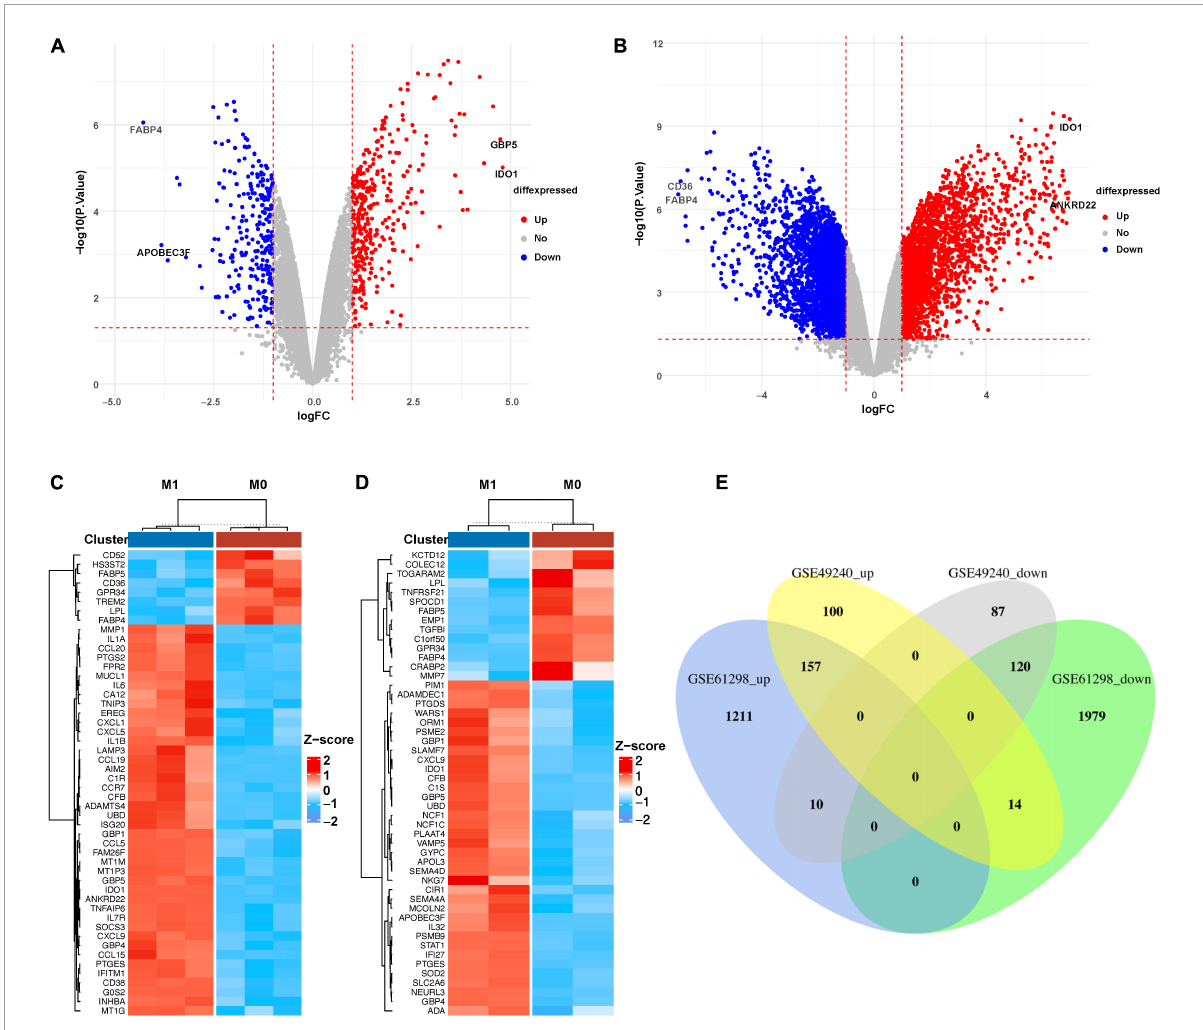
FIGURE1 Identification of DEGs in M1 macrophages datasets. (A) Volcano diagram of DEGs in GSE49240 and (B) volcano diagram of DEGs in GSE61298, the cut-off value of –log10( P -value) is –log10(0.05), cut-off value of |log 2 fold change| is 1, red and blue, respectively, represent relatively high and low expression of the mRNA. (C) Heatmap of DEGs in GSE49240 and (D) heatmap of DEGs in GSE61298 showed the mRNA expression of M1 macrophages and M0 macrophages, with red representing up-regulation and blue representing down-regulation. The panels showed the top 50 DEGs ranked by |Log2fold change|. (E) Venn diagram of the overlapping DEGs from two datasets, GSE49240 and GSE61298, identified a total of 157 up-regulated and 120 down-regulated DEGs, with different colors representing different